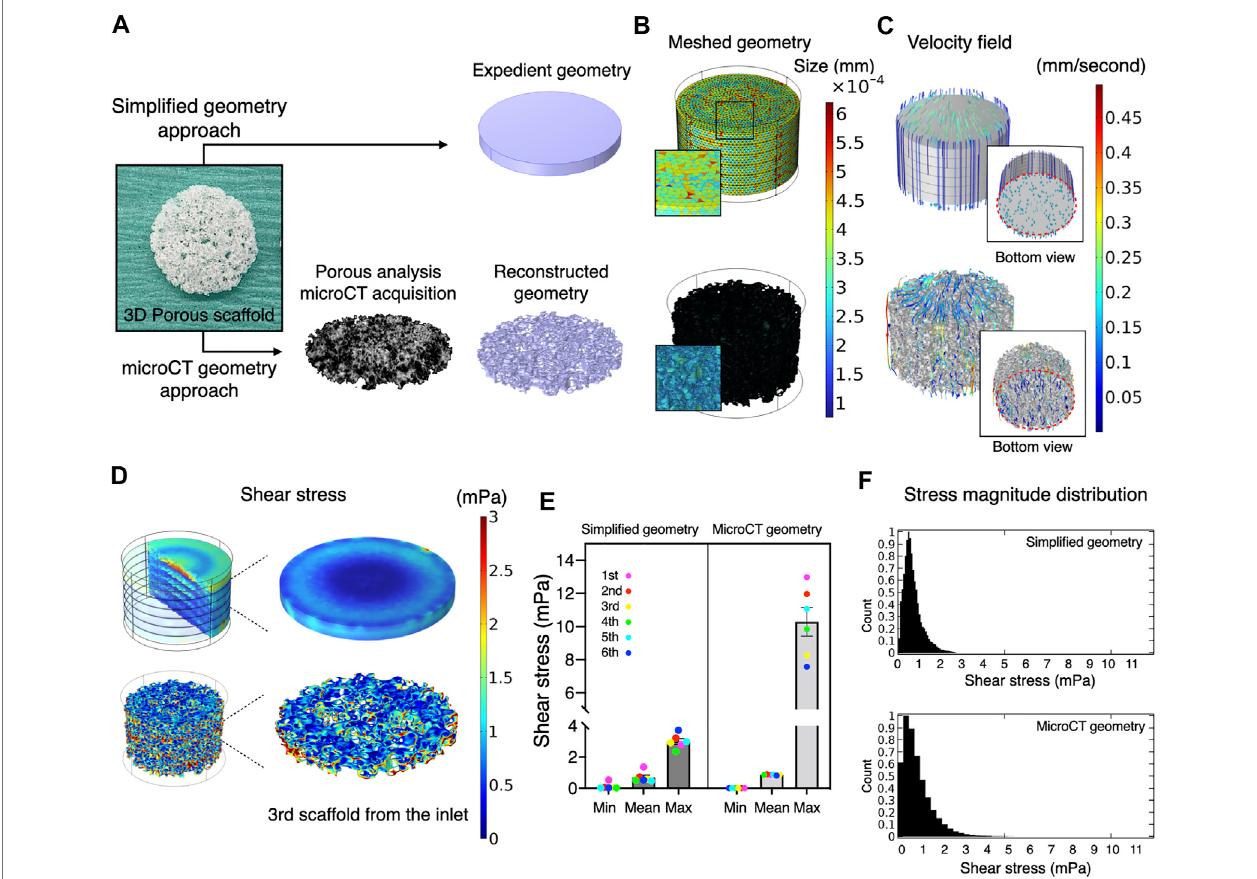
FIGURE 2 | Comparative validation of different modeling methods in fl uid dynamics simulation. (A) A three-dimensional porous scaffold was modeled by different methods.Forthesimpli fi edgeometryapproach,thescaffoldwasassignedasaporousdomainparameterizedwithporosityandpermeability.ForthemicroCTgeometry approach, an acellular scaffold was scanned by microCT, and the geometry was imported as a .stl fi le in CAD software. (B) The reconstructed geometry was then meshed for computation. The element size of simpli fi ed geometry was signi fi cantly smaller than that of the microCT geometry. (C) At a fl ow rate of 0.8 ml/minutes, mediumpermeateduniformlyinsidethescaffoldsat fl owvelocitiesrangingfromnearly0to0.5 mm/secondinbothmodels. (D) Estimatedmagnitudeofshearstresswas more patterned in the expedient geometry than in the microCT geometry. The microCT geometry offered more locally speci fi c variation. (E) Estimated mean and minimum but not maximum shear stress in the simpli fi ed approach was compatible with the microCT approach. (F) The distribution of shear stress magnitude shows monophasic peak around 0.5 – 1 mPa both in the simpli fi ed and microCT approaches.